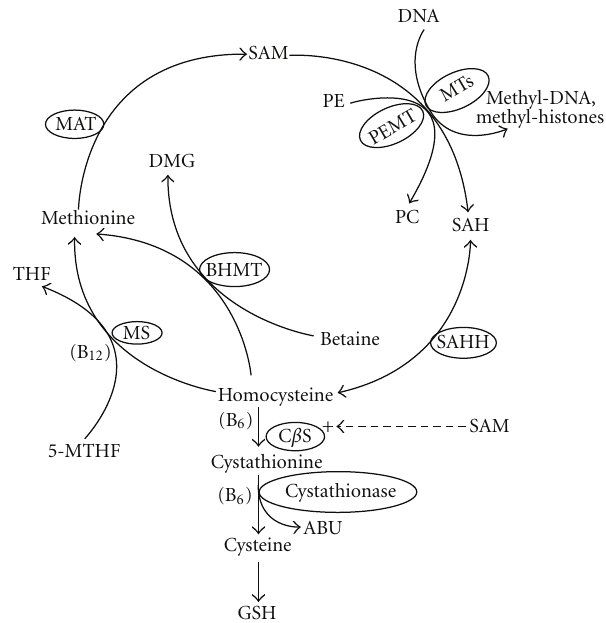
Figure 1: Normal hepatic methionine metabolism.